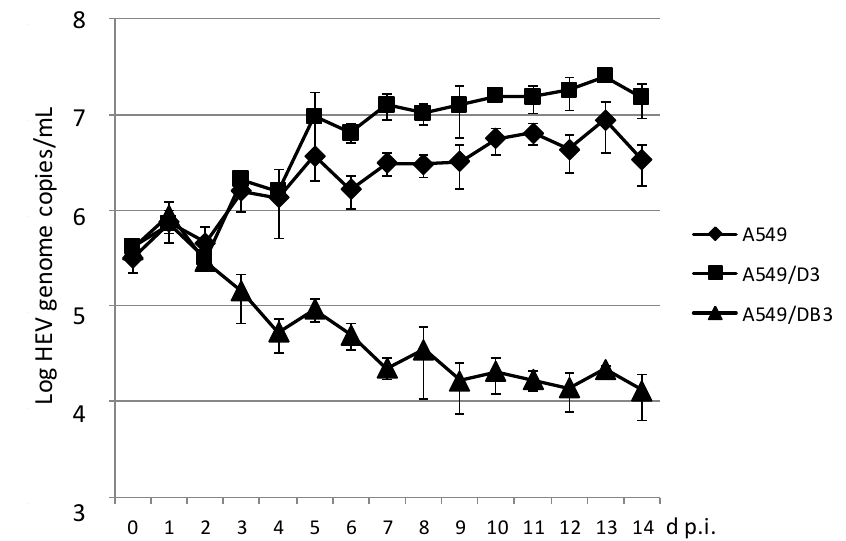
Figure 3. Time-course analysis of HEV strain 47832c replication in A549 cells and in the clonal cell lines A549/D3 and A549/DB3. The HEV genome copy number present in the culture supernatant was analyzed daily and the mean copy number and the standard deviation (error bars) of three replicates each are shown.